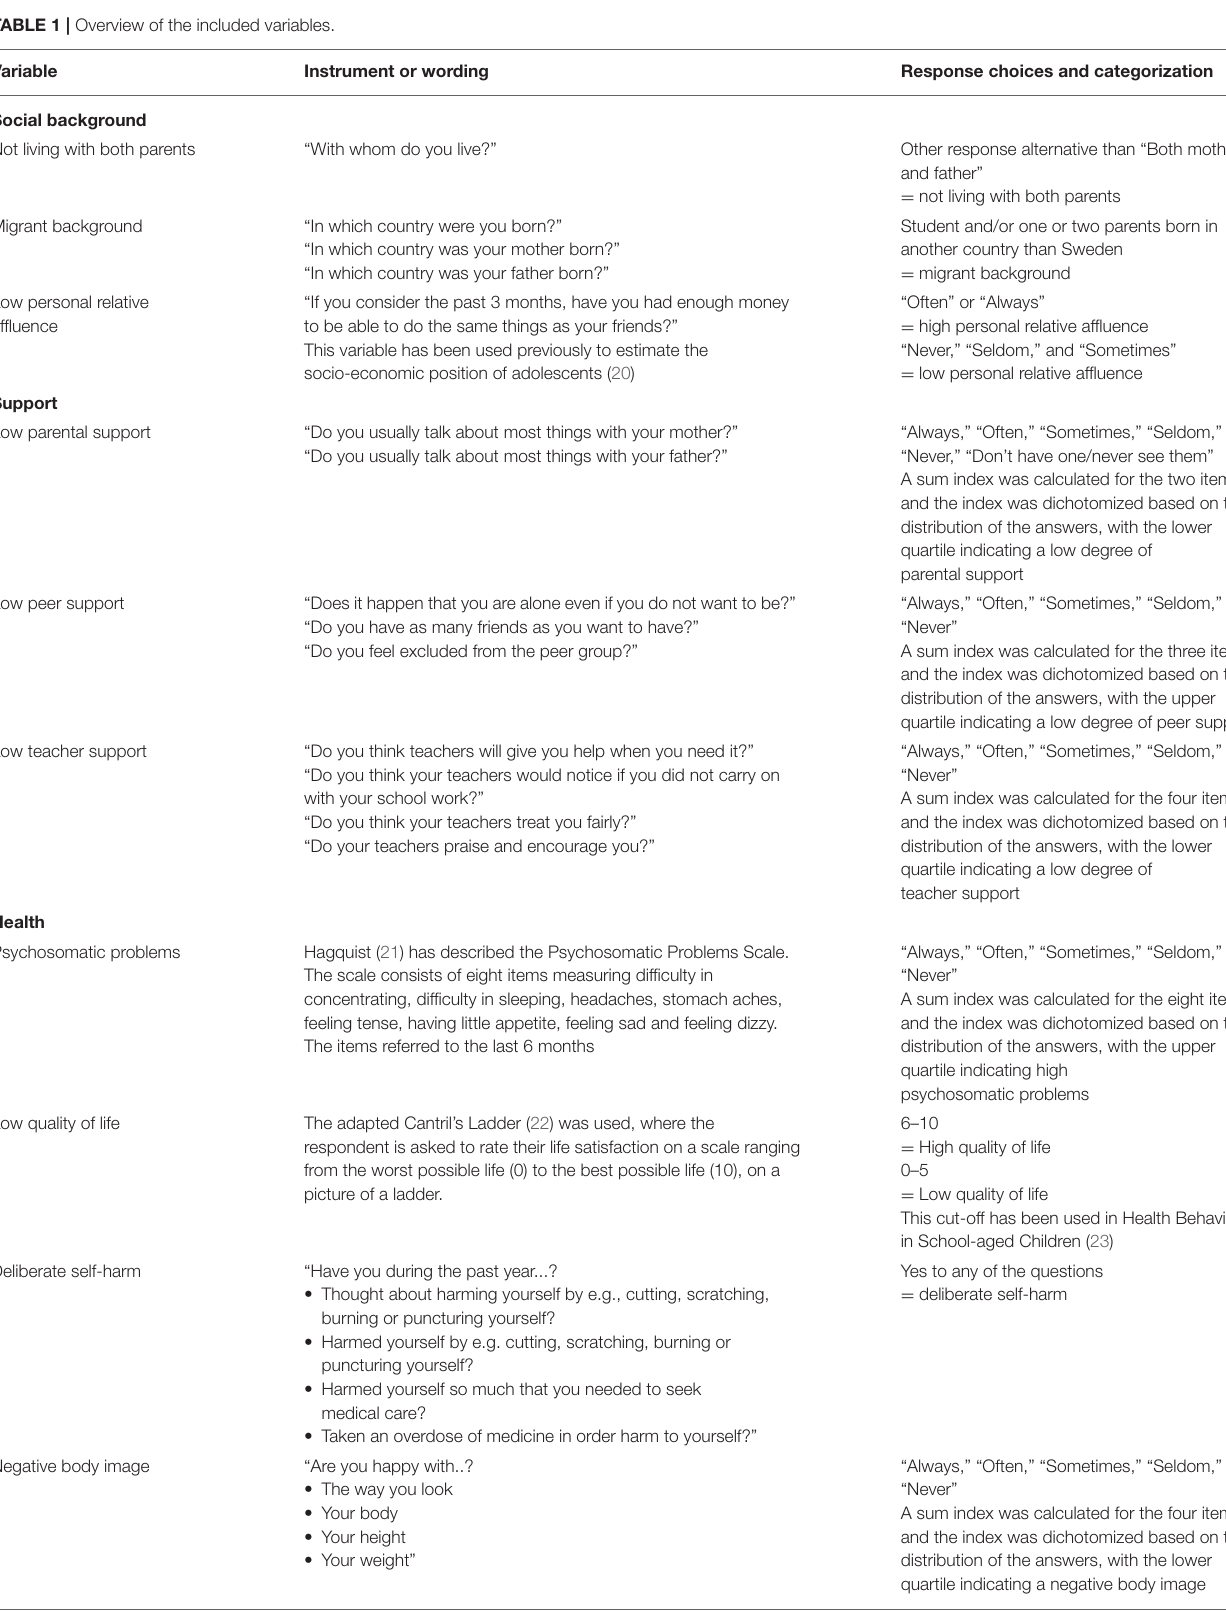
TABLE 1 | Overview of the included